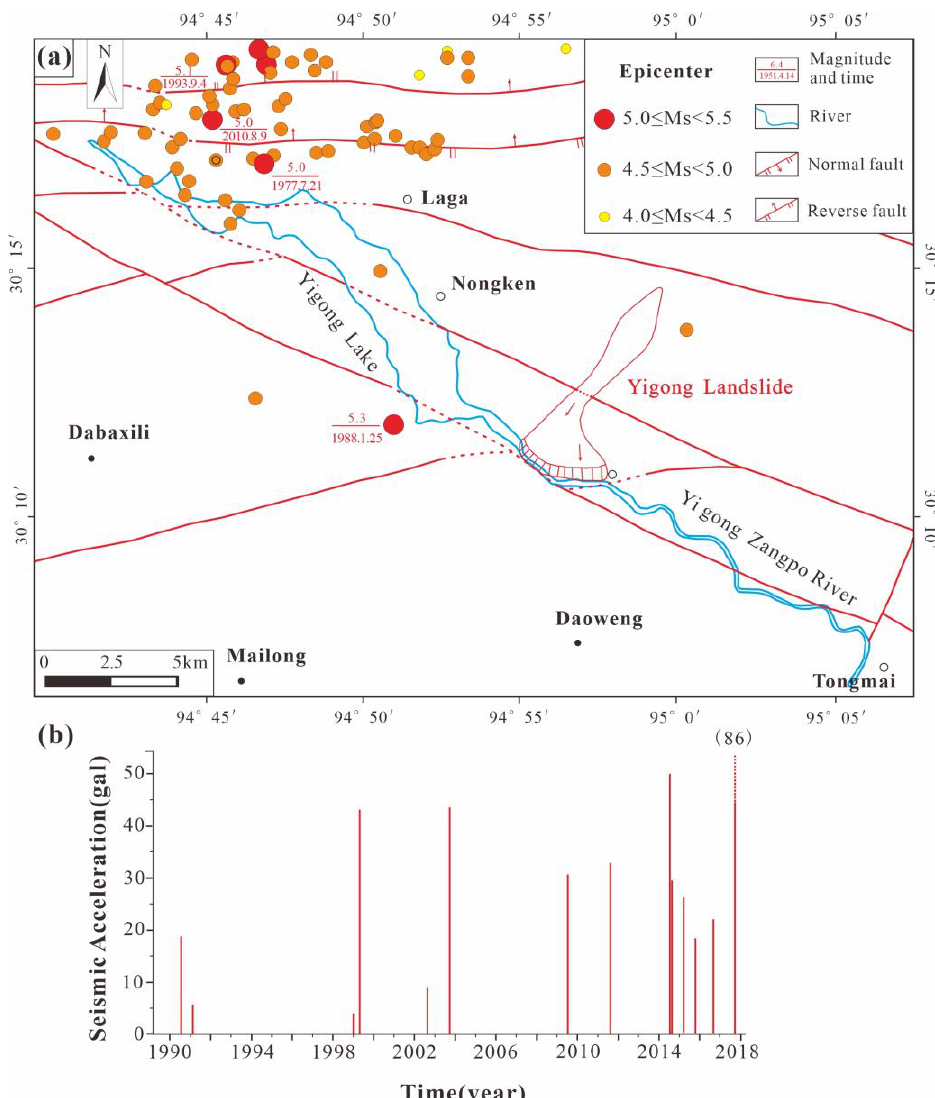
Figure 2. Earthquake distribution and acceleration around Yigong landslide. ( a ) The epicenter distribution around the Yigong landslide since 1970; ( b ) The curve of acceleration since 1990.